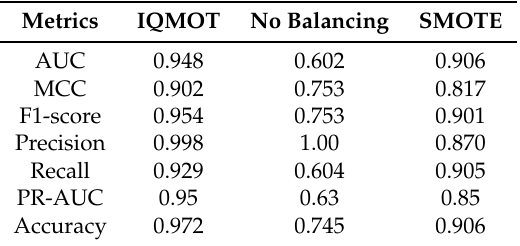
Table 8. IQMOT-based performance comparison.